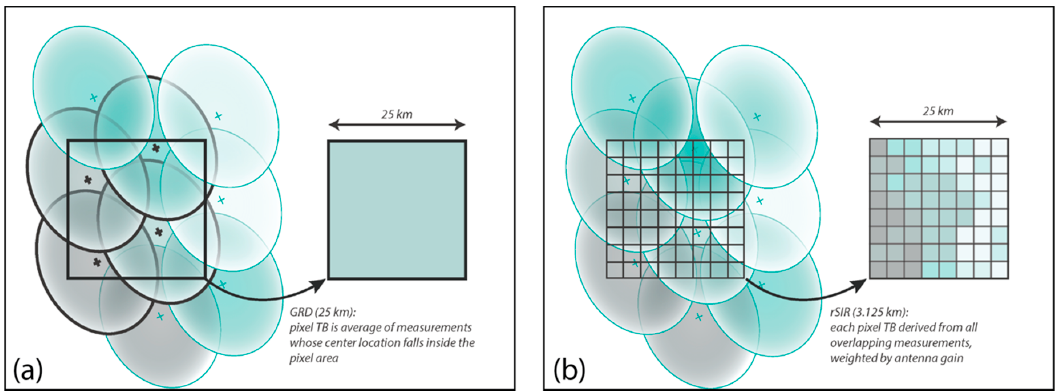
Figure 1. Schematics of (a) drop-in-the-bucket (GRD) method where all footprints whose centers are within the grid cell are averaged, and (b) rSIR where the sensor footprints are weighted based on the measurement response function to obtain enhanced resolution. Figure adapted from the Calibrated Enhanced-Resolution Passive Microwave Daily EASE-Grid 2.0 Brightness Temperature (CETB) product user’s guide [21].